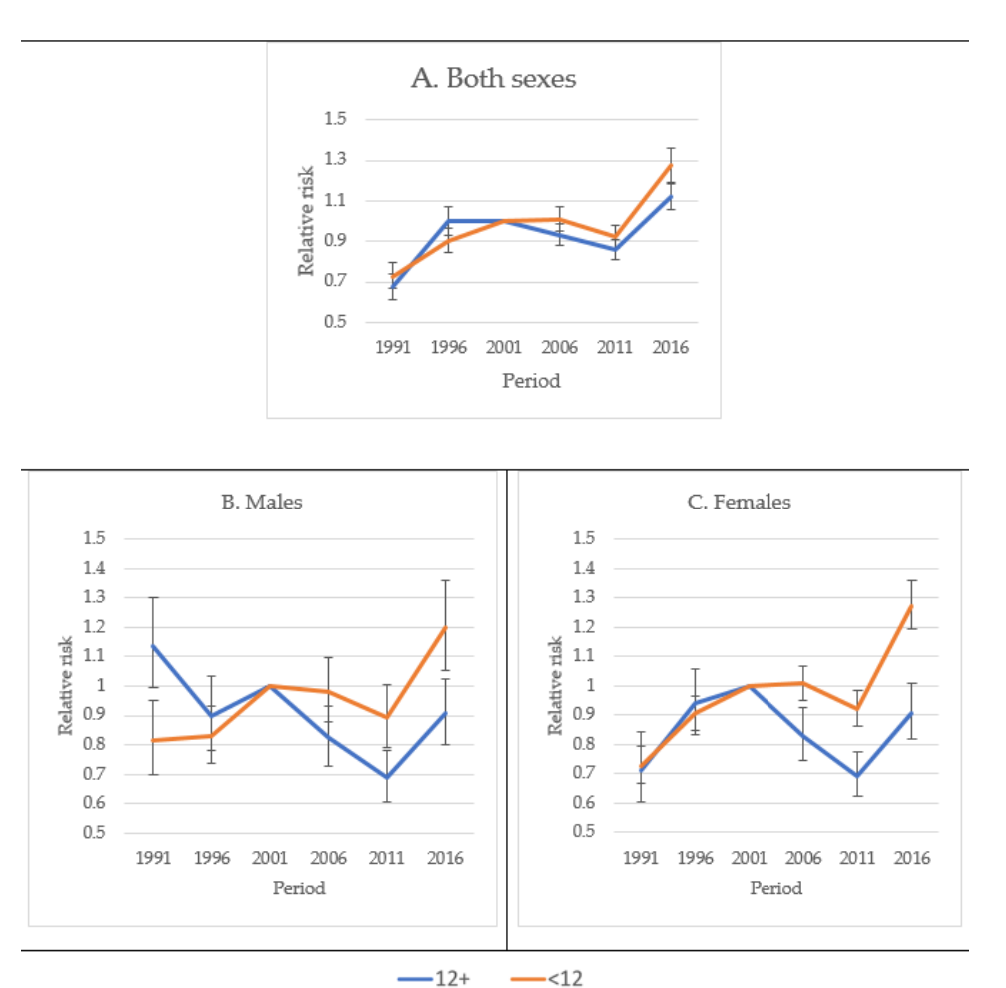
Figure 6. The relative risk of age-adjusted diabetes mortality among Hispanics by sex, year of death, and education level, USA 1989 – 2018. RR (Relative Risk) was compared to mortality in the year 2000.